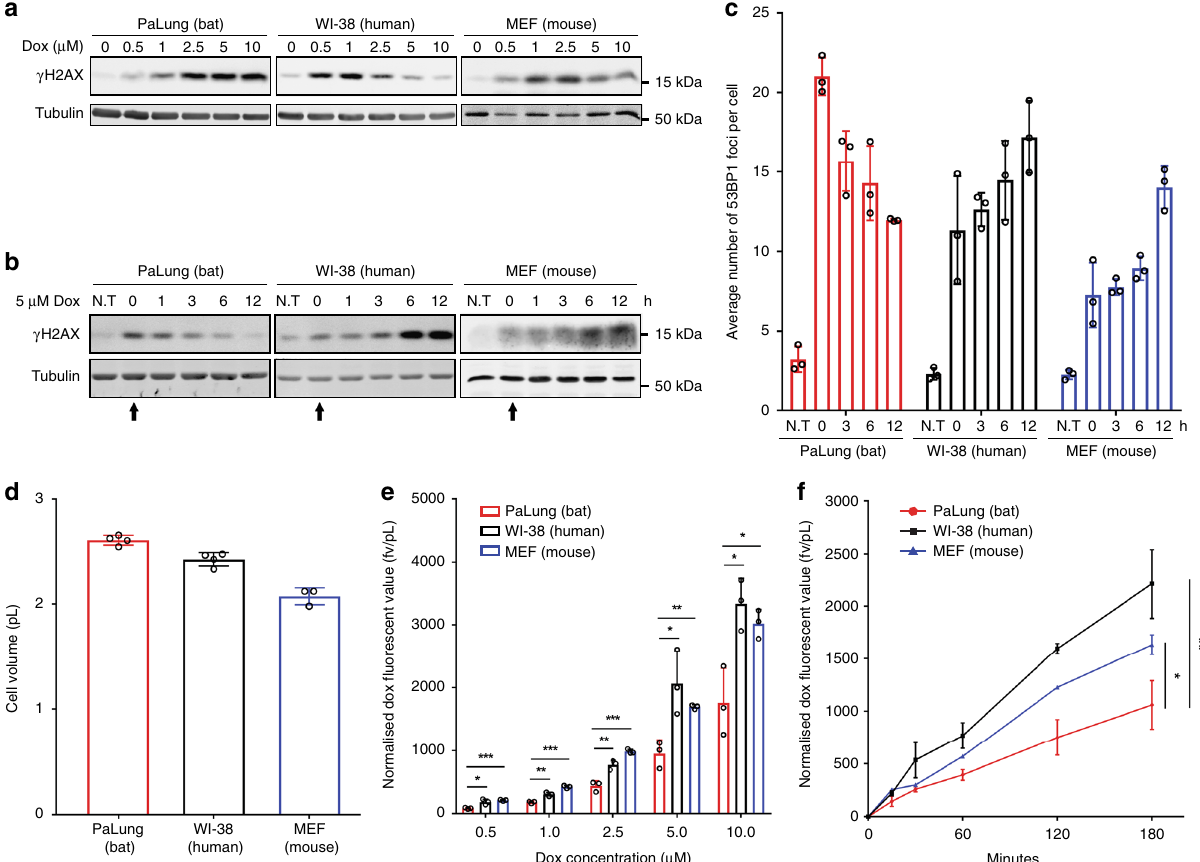
Fig. 2 Analysis of γ H2AX, 53BP1, and intracellular accumulation of doxorubicin in bat, human, and mouse cells. a Dose titration of doxorubicin (Dox) in PaLung, WI-38 and MEF cells. Cells were treated with the indicated doses of doxorubicin for 3 h, and protein lysates were analysed by Western blotting. Tubulin was used as a loading control. b Western blot analysis of γ H2AX in PaLung, WI-38 and MEF cells treated with 5 μ M Dox for 3 h, followed by drug- free medium up to 12 h (starting at t = 0 h, indicated by arrow). Protein lysates were harvested at the indicated time points. Tubulin was used as a loading control. N.T stands for no treatment. c Analysis of the average number of 53BP1 foci per cell for PaLung, WI-38 and MEF cells. Cells were treated with 5 μ M Dox for 3 h, followed by drug-free medium up to 12 h. Immuno fl uorescence staining of 53BP1 was performed at the indicated time points. The number of foci in a minimum of 100 cells was quanti fi ed. N.T stands for no treatment. d The volume of the indicated cell lines. e Doxorubicin accumulation in PaLung, WI-38 and MEF cells after 3 h of incubation at the indicated concentration. The amount of accumulated doxorubicin in cells was analysed by fl ow cytometry. The mean fl uorescence value (fv) of doxorubicin is normalised to cell volume (pL). f Time course of doxorubicin accumulation in PaLung, WI- 38, and MEF cells. Cells were treated with 5 μ M doxorubicin for the indicated time and analysed by fl ow cytometry. The mean fl uorescence value of doxorubicin accumulated in each cell line is normalised to cell volume. All Western blot results shown are representative of at least three experimental repeats. Bars represent the means ± SDs of at least three independent experiments. Statistical signi fi cances were calculated using unpaired student ’ s two- sided t test. p < 0.05 is represented with *, p < 0.01 with ** and p < 0.001 with